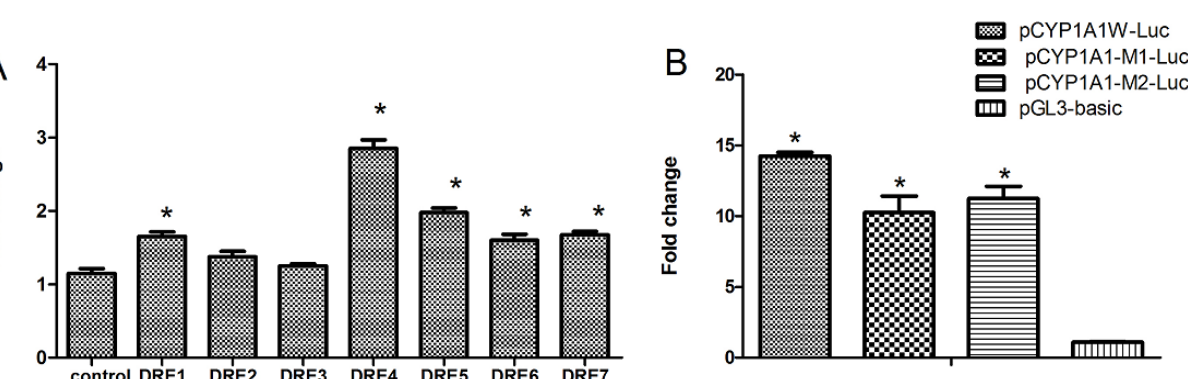
Figure 3. The AhR-dependent transcriptional efficiency of the seven putative DREs are different. The following constructs were transiently transfected into cultured Hepa WT cells one day before drug treatment: seven mouse CYP1A1 promoter-reporter constructs, each of which contains one DRE site, the control vector pGL3-promoter ( A ) or ( B ) pCYP1A1W-Luc, which contains the 1.4-kb CYP1A1 promoter sequences, pCYP1A1-M1-Luc and pCYP1A1-M2-Luc, which contain mutations of the DRE at position -981 (DRE4), and the control vector pGL3-basic. After one day of treatment with TCDD (10 − 9 M) or with solvent alone at 0.1% (control), luciferase assays were performed to determine the promoter activity of mouse CYP1A1. * p < 0.05, the difference from solvent-treated cells (control) by one-way ANOVA with Tukey’s